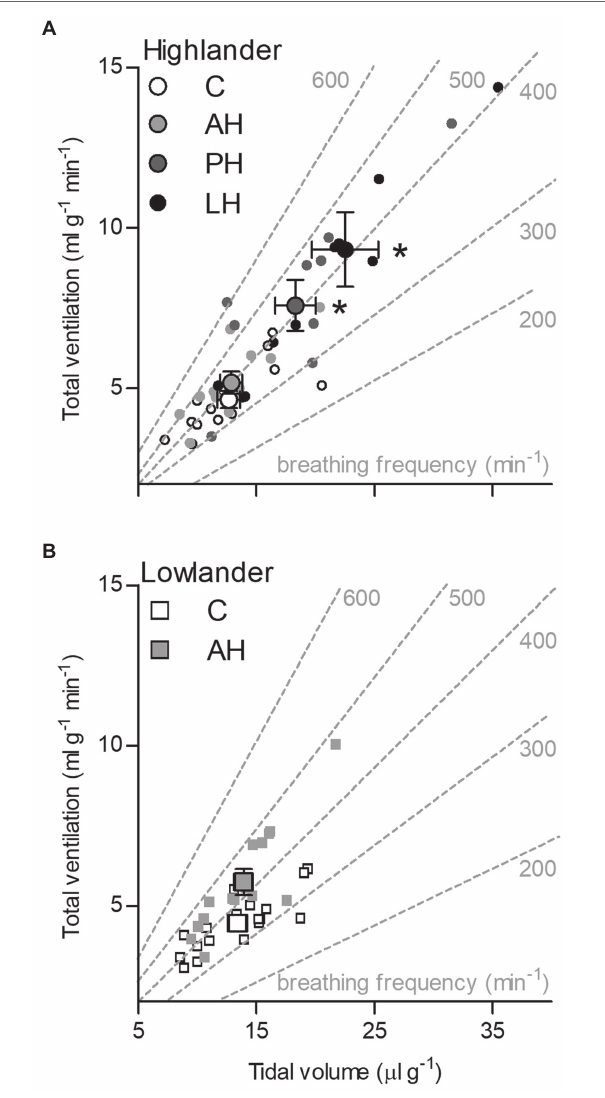
FIGURE 4 | The effects of developmental hypoxia on total ventilation in highland deer mice (A) arose from increases in maximal tidal volume, with no change in breathing frequency, in contrast to lowland mice (B) . Gray dashed lines represent isopleths of constant breathing frequency. Large symbols with error bars indicate mean ± SEM and small symbols represent individual values. Lowland mice were unable to raise litters in the PH or LH groups. Bars indicate mean ± SEM and symbols represent individual values. Treatment groups are shown in Figure 1 with N as follows: 14 control (C), 12 acute hypoxia (AH), 9 post-natal hypoxia (PH), and 9 life-long hypoxia (LH) for highlanders; 18 C and 16 AH for lowlanders. *Significant pairwise difference from control within each population using Holm-Sidak